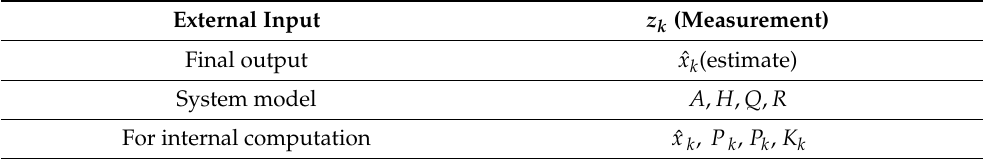
Table 1. Variables Used in Kalman